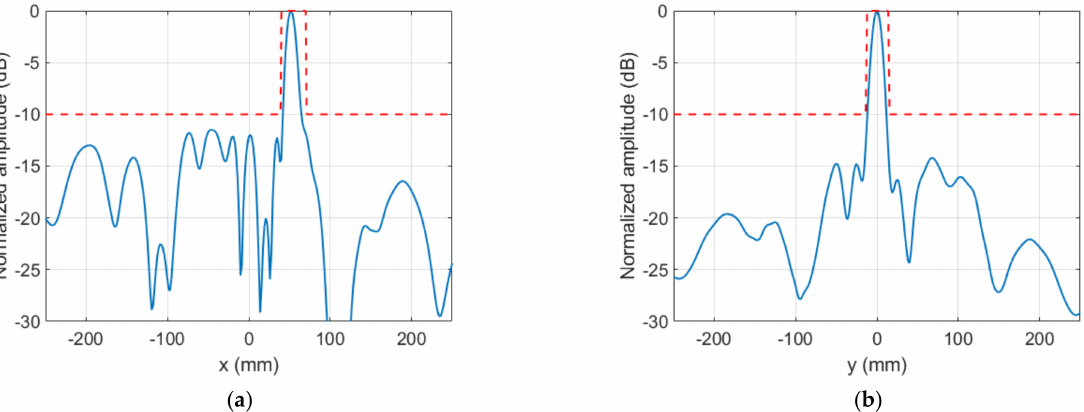
Figure 16. Case 2, Stage#3: main cuts of NF distribution ( E NF ) and comparison with templates: ( a ) cut y = 0; ( b ) cut x = 51.92